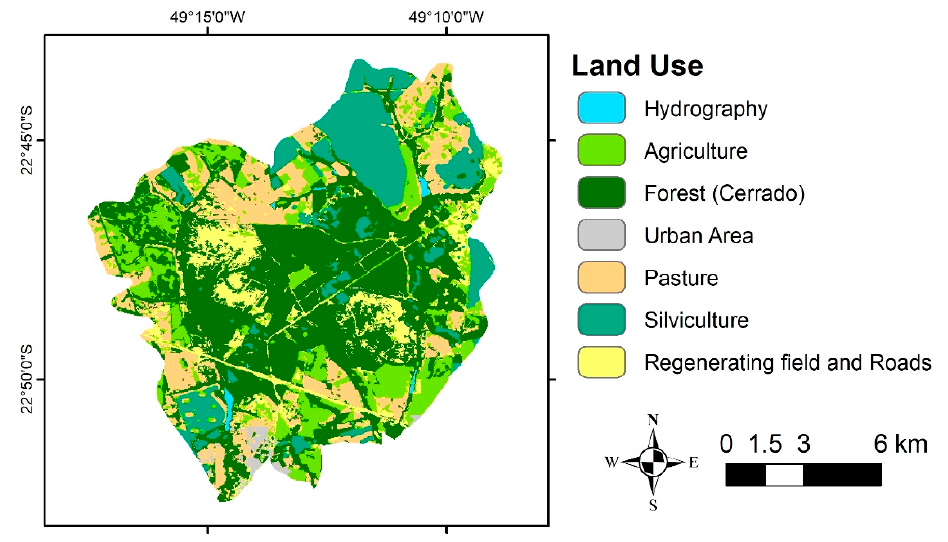
Figure 2. Basic land use of watersheds, from the day of year (DOY) 75/2017.